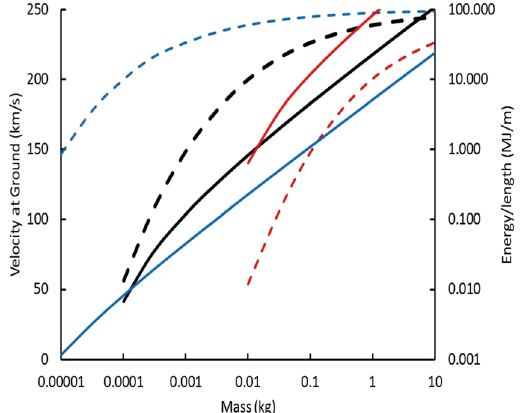
Figure 2. The velocity of 250-km/s quark nuggets after passage through the atmosphere (dashed line) and the energy per unit length (solid line) deposited by them in passing through the first 3 m of 1120-kg/m 3 aqueous liquid for surface magnetic field B o = 10 11 T (blue), 10 12 T (black), and 10 13 T (red). The three values of magnetic field cover the uncertainty in Tatusmi’s calculated magnetic field B o = 10 12 + / − 1